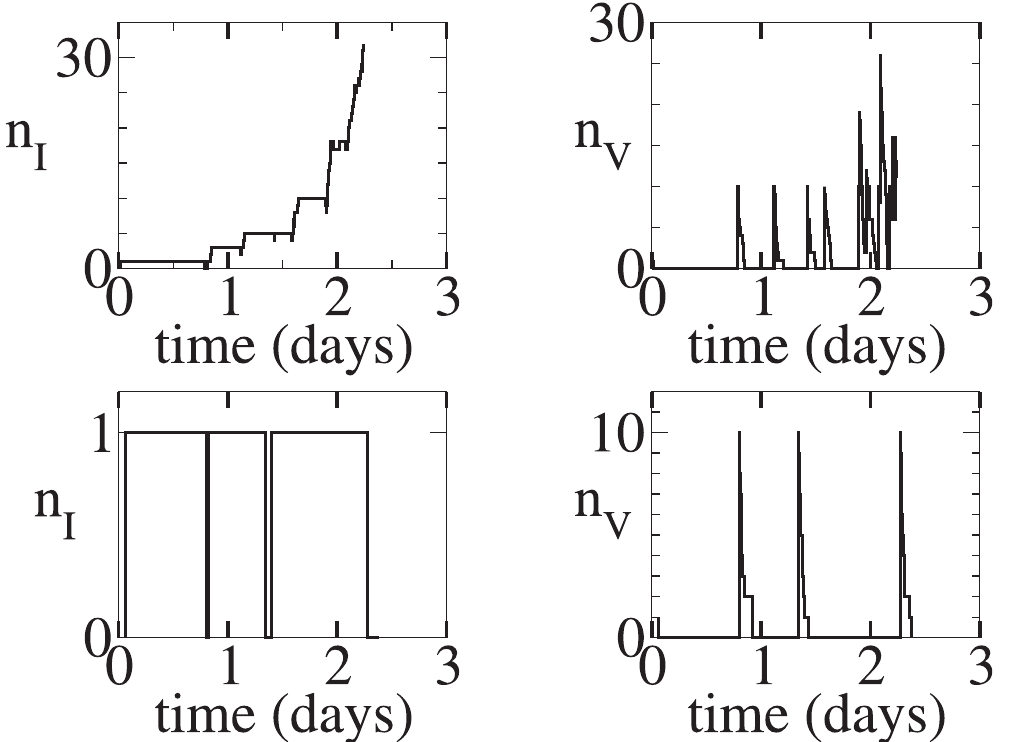
Figure 4. Burst model time series. Initial conditions: n V (0) ~ 1, n I (0) ~ 0 . Top left: n I versus t for a realization that leads to infection. Top right: n V versus t for the same realization. Bottom left: n I versus t for a realization that leads to extinction. Bottom right: n V versus t for the same realization. kT ~ 10 = day , c ~ 20 = day , and N ~ 10 .